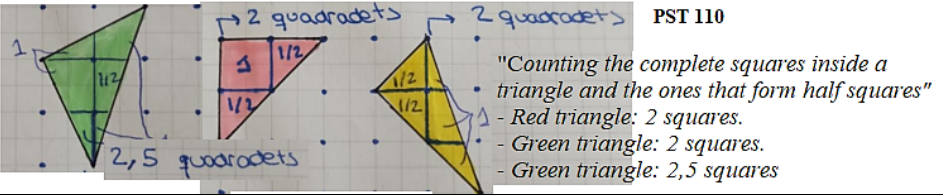
Figure 14. Excerpt from the teacher’s intervention during the connection CC9.